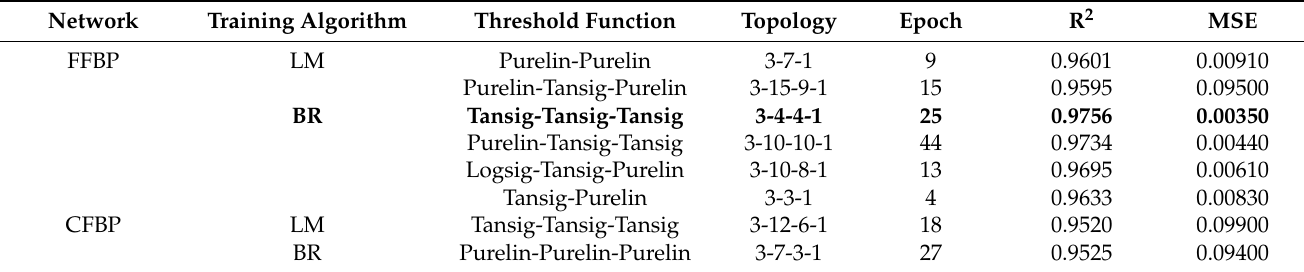
Table 5. Best topologies included in training algorithms, various layers and neurons for estimation of AOA (DPPH). Network Training